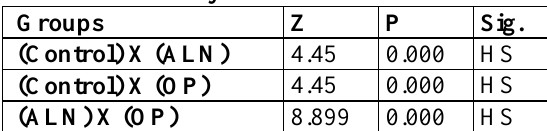
Table 3: Inter group comparisons of salivary OPG concentration.